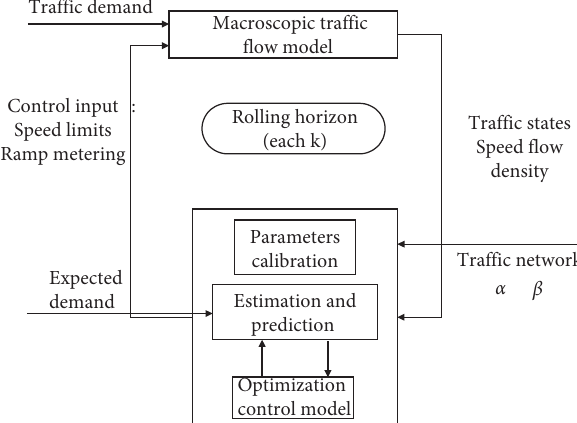
Figure 2: Simulation structure.